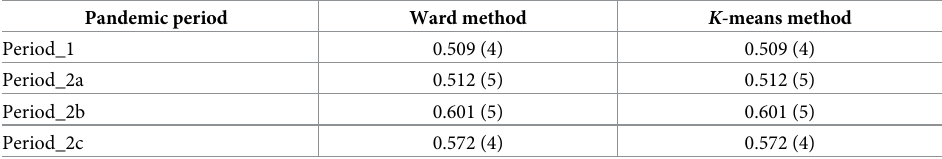
Table 7. Silhouette coefficients for three variables: e P ; e σ ; f W .